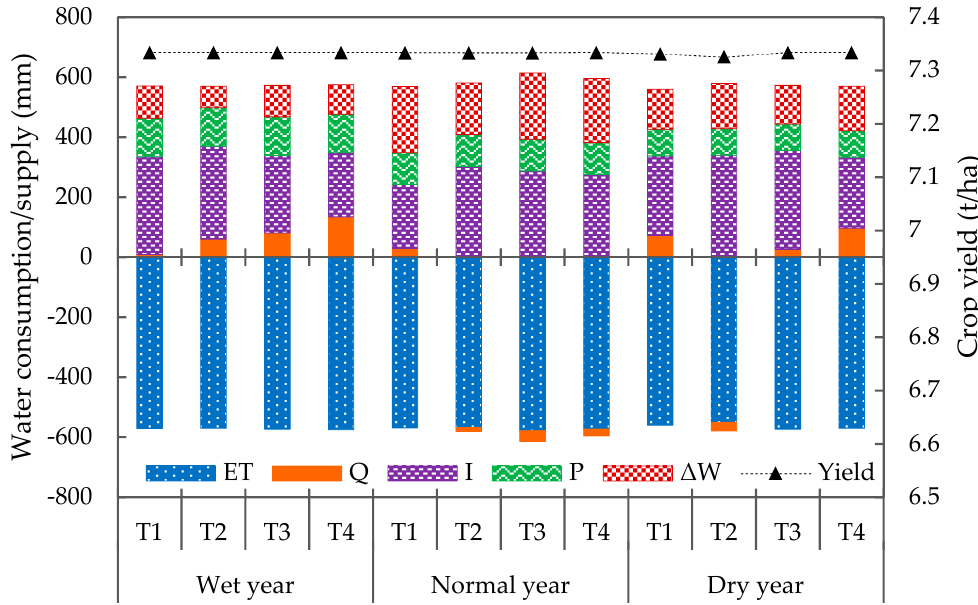
Figure 10. Soil water consumption and supply (positive means supply, negative means consumption, ET means evapotranspiration, Q means deep percolation, ∆ W means changes in water storage) under different climate changes. Table 4. Optimal irrigation schedules under different soil types in Danman Irrigation District under different climate changes.